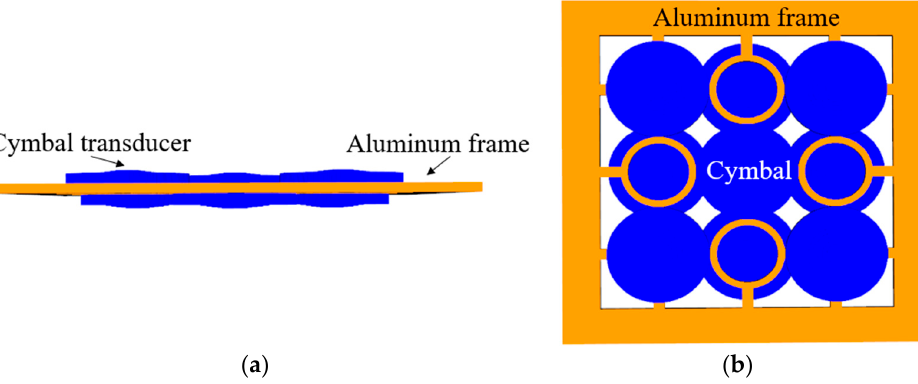
Figure 2. Schematic of the double-layered cymbal array: ( a ) front view; ( b ) top view.